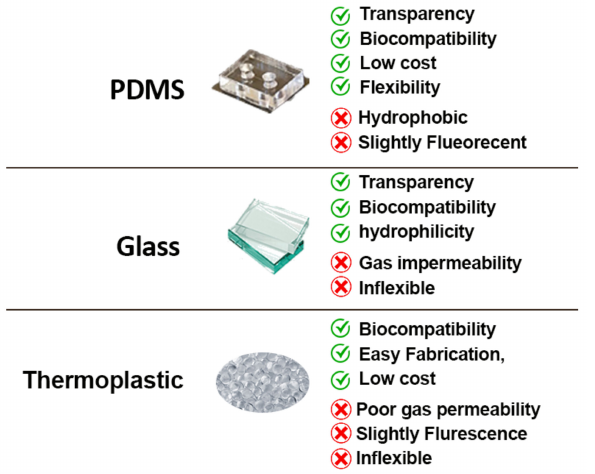
Figure 5. Common materials used for OOCs. The most important features for selecting the materials for the structure are biocompatibility, transparency, and the